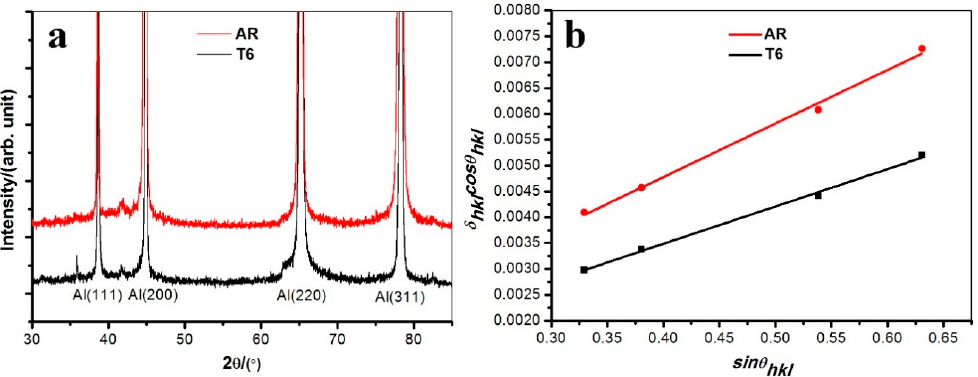
Figure 4. ( a ) comparison of XRD peaks of the T6-treated and AR samples, ( b ) plotting δ cos θ vs. sin θ and performing a linear regression analysis.